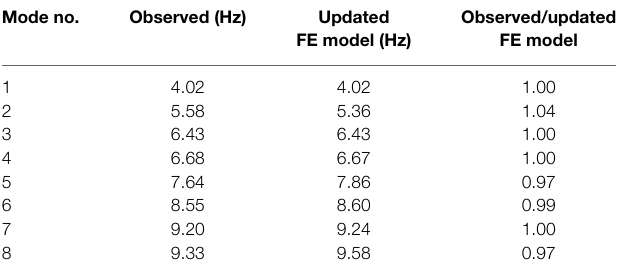
TABLE 7 | Results of stiffness updating for the building after the earthquake: comparison of observed natural frequencies with the analytical ones of the updated finite element